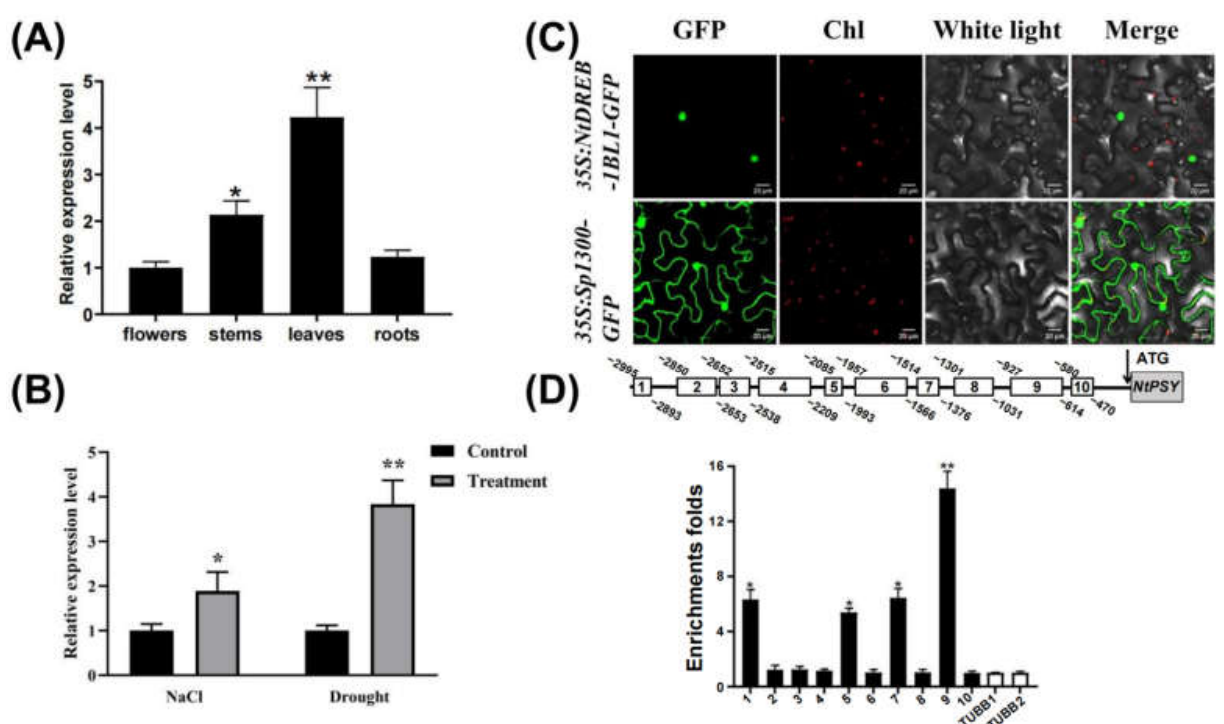
Figure 2. Expression pattern, subcellular localization, and ChIP-qPCR of NtDREB-1BL1. ( A ) The relative pattern of NtDREB-1BL1 in various tissues. ( B ) Relative expression of NtDREB-1BL1 in response to drought and NaCl stresses. Relative expression was evaluated by qPCR using 26s rRNA as a reference gene. Asterisks represent statistically significant differences by Student’s t -test (**, p < 0.01; *, p < 0.05). ( C ) Subcellular location of NtDREB-1BL1 proteins fused to GFP (green color) in tobacco. Chl, chlorophyll autofluorescence (red color). ( D ) The enrichment of binding fragments was examined by ChIP-qPCR. The black line represented the 3 kb sequence upstream of the ATG of the NtPSY gene. The white boxes represented the DNA fragments amplified in the ChIP assay. ChIP enrichment test of the promoter regions bound by NtDREB-1BL1 was examined by